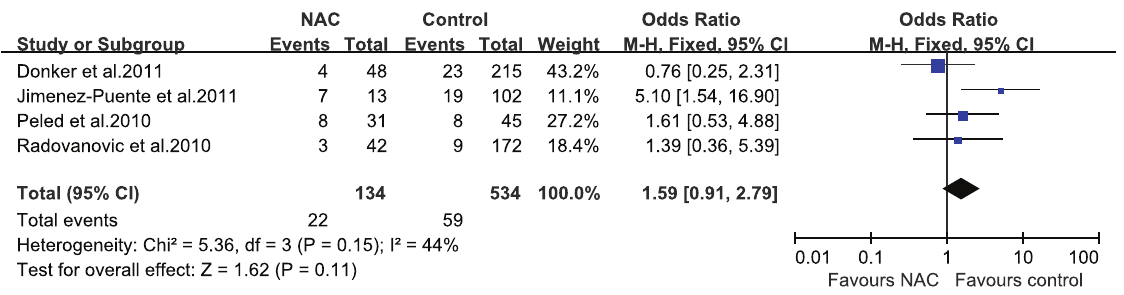
Figure 7. Pooled results of E/I loss in patients treated with NAC. The size of the solid squares is inversely proportional to the variance of the study estimate. The diamond represents the fixed effects odds ratio and 95% confidence interval.